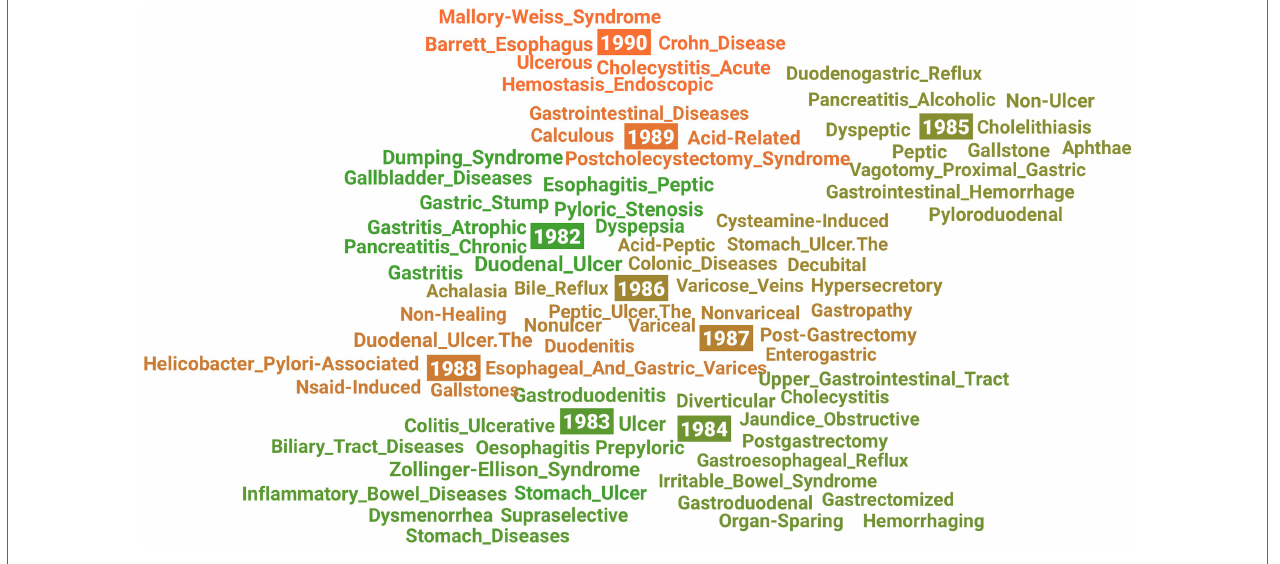
FIGURE 6 | Visualization of the semantic change in research on Peptic Ulcer from 1982 (green) to 1990